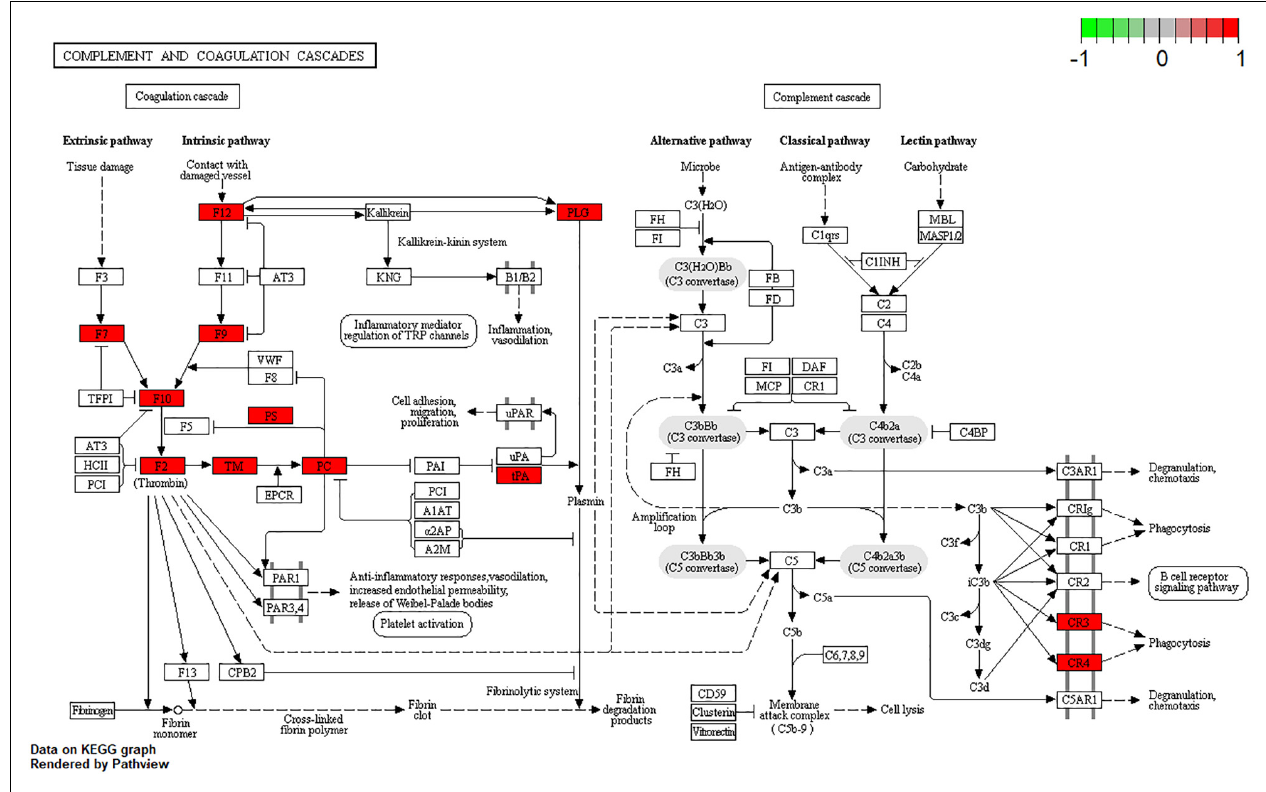
FIGURE 9 | Complement and coagulation cascades signalling pathway. The red square represents targets of EJSW against ITP.